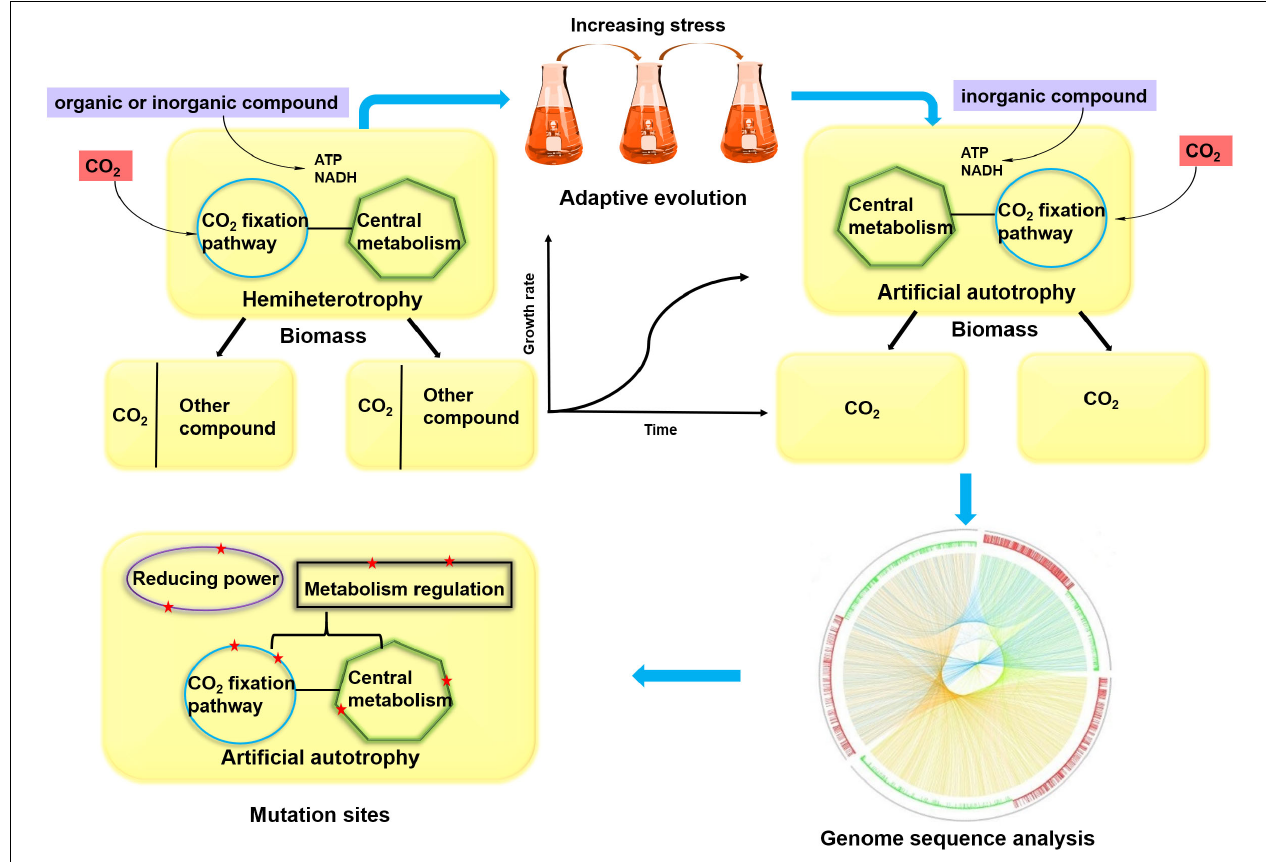
FIGURE 3 | The conversion process of hemiheterotrophy to artificial autotrophy. In hemiheterotrophic microorganism, CO 2 was fixed into organic carbon via introducing CO 2 fixation pathway and organic or inorganic compound provided reducing power and energy. Biomass was derived from CO 2 and another compound. The artificial autotrophic microorganism can be obtained through ALE strategy, in which inorganic compound provided reducing power and energy and biomass was completely derived from CO 2 . To understand the genetic basis for adaptation to autotrophy, genomic analysis can be carried out, and mutation sites were related to CO 2 fixation pathway, central metabolism, reducing power and metabolism regulation (depicted by red